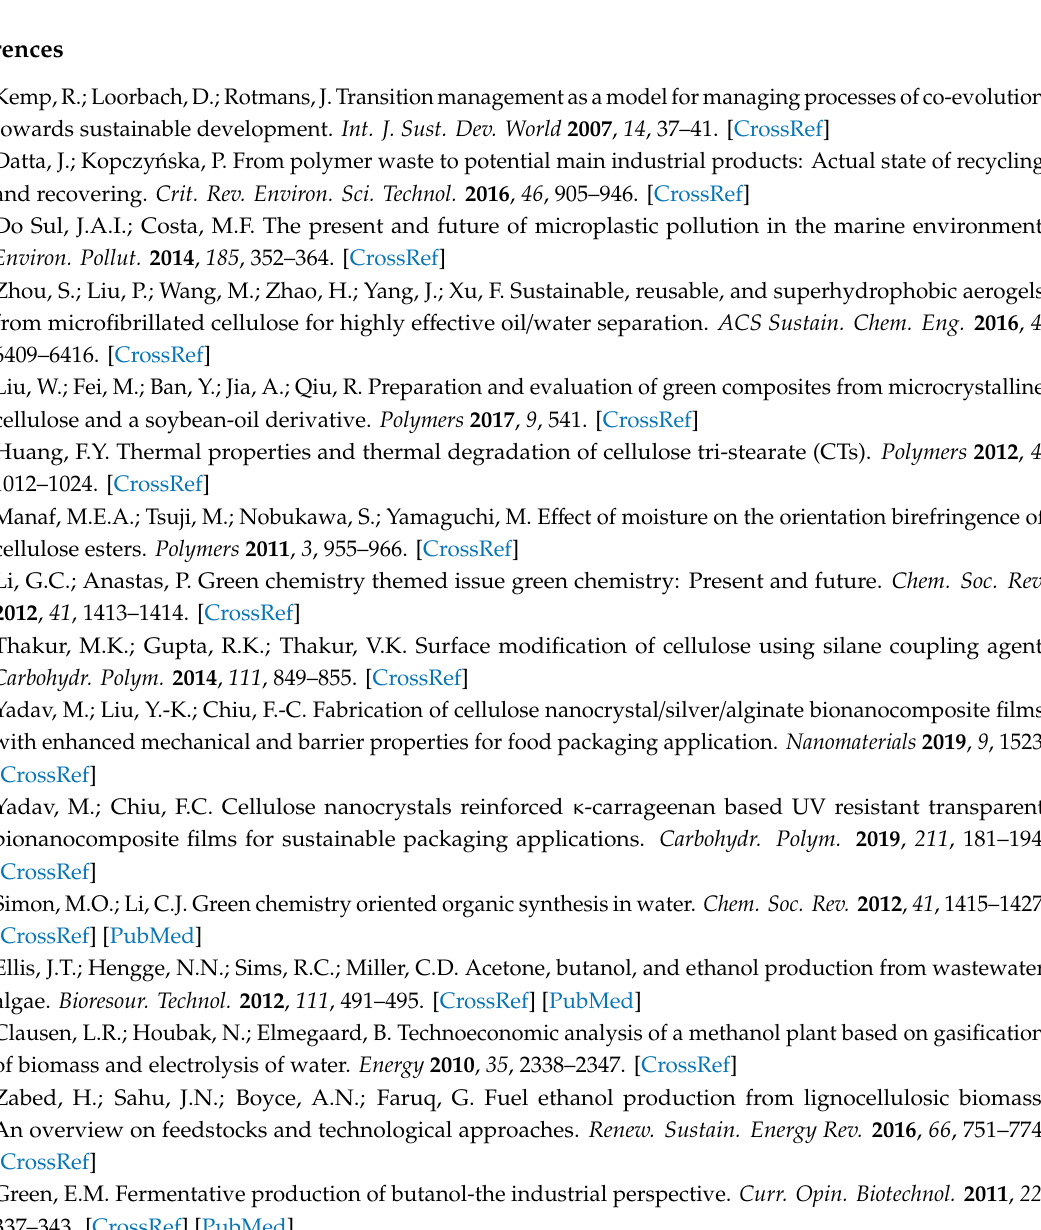
Figure S2. NIR spectra of cellulose fibers dried for 45, 90, 180, 1440 minutes at 100 ◦ C. Figure S3. Comparison of dried and not dried cellulose water evaporation phenomenon according to the DSC curves. Figure S4. TGA curves of analyzed composites filled with cellulose fibers dried for di ff erent times. Figure S5. DSC curves of analyzed composites filled with cellulose fibers dried for di ff erent times. Figure S6. Surface free energy of investigated composites filled with modified cellulose fibers. (a) not dried before the modification process, (b) dried before the modification